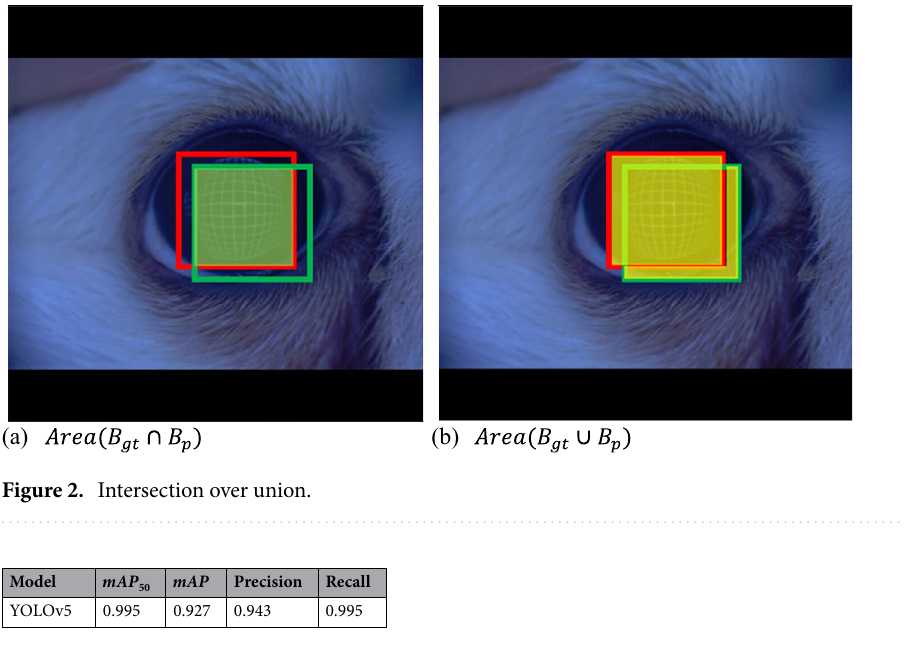
Table 1. Object detection